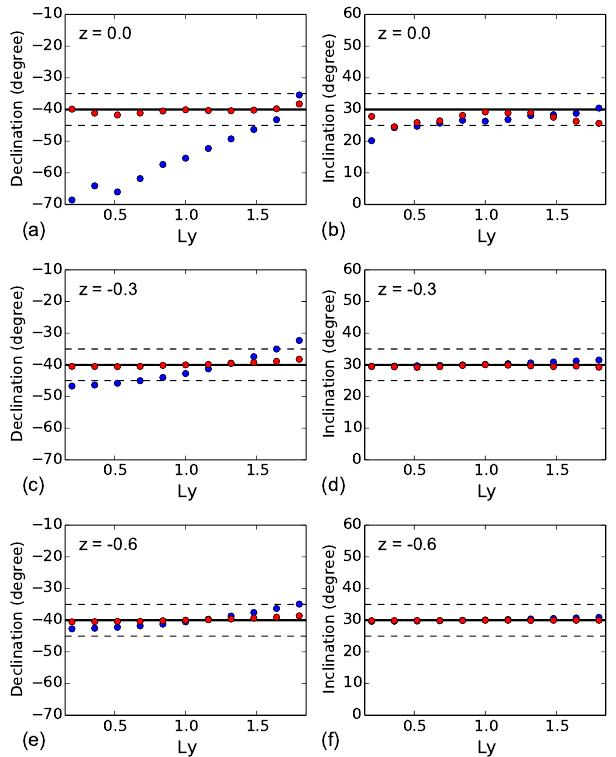
Figure 6. Robustness against non-spherical sources. The blue and red dots represent, respectively, the results obtained with the least- squares ˆ h (Eq. 19) and robust e h (Eqs. 21 and 22) estimates. Each dot represents an estimated declination or inclination obtained from the total-field anomaly produced by a rectangular prism with a dif- ferent Ly (Fig. 4). z indicates the constant vertical coordinate of the planar surface on which the total-field anomaly was calculated (dashed lines in Fig. 4b). The continuous black lines represent the true declinations (or inclinations). The dashed lines represent the true declination (or inclination) ± 5 ◦